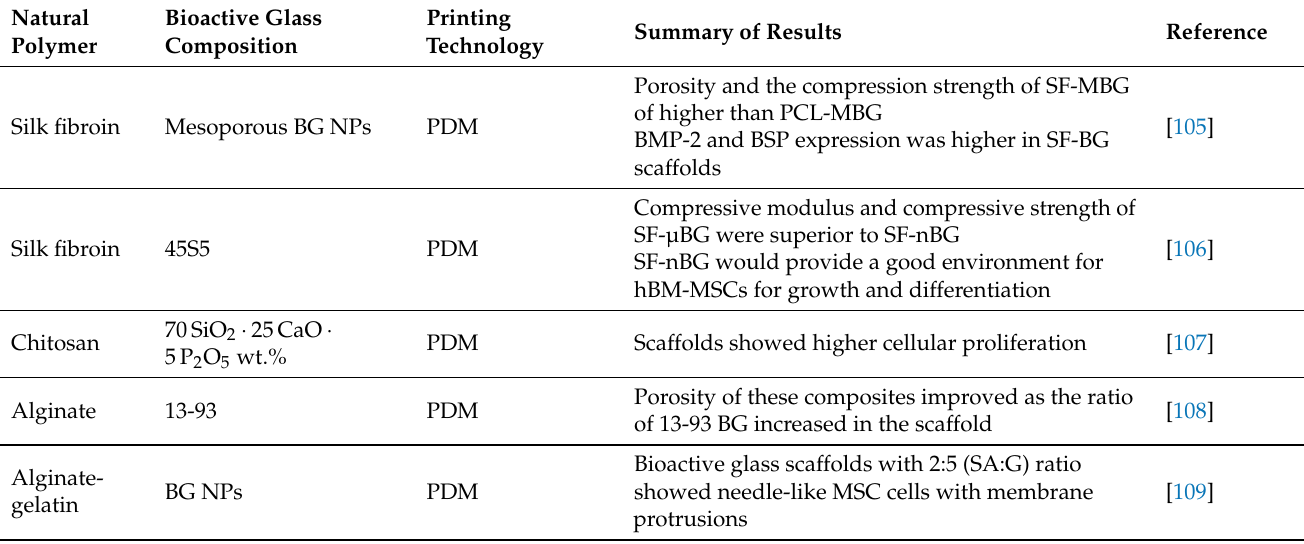
Table 3. Result summary of studies on 3D-printed natural polymer-bioactive glass